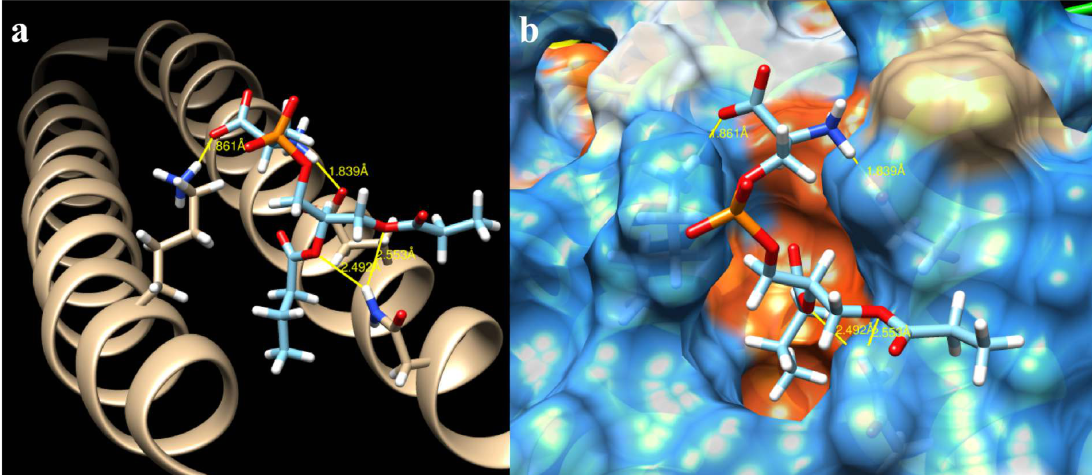
Figure 5. CagA–PS interaction of the mutation K636N obtained from Chimera: ( a ) hydrogen bonds and their distance (yellow lines) of interacting atoms are shown for both molecules; and ( b ) kydrophobic surface view of CagA, color-coded from dodger blue for the most hydrophilic, to white, to orange-red for the most hydrophobic.